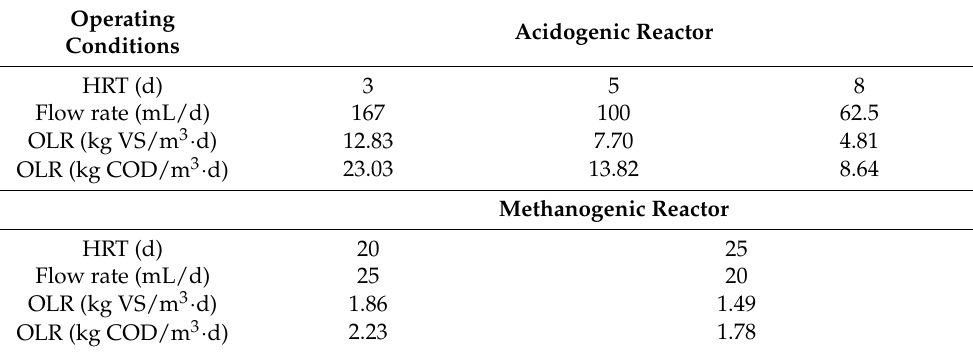
Table 2. Operating conditions of CSTRs for the HRT effect